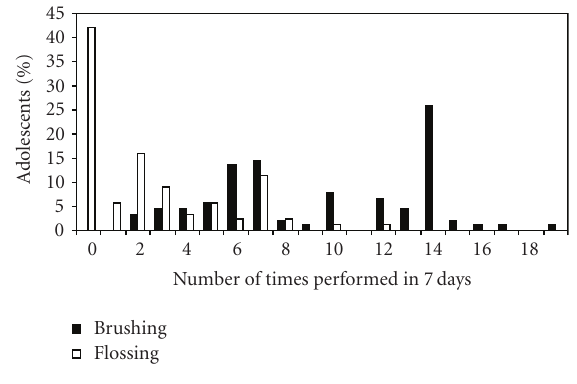
Figure 1: Frequency of toothbrushing and